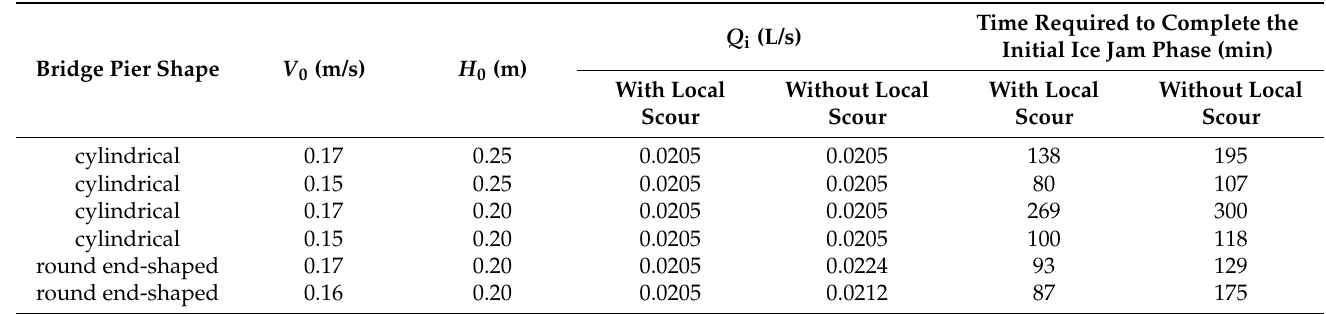
Table 3. The time required to complete the development of an initial ice jam phase with and without local scour conditions.